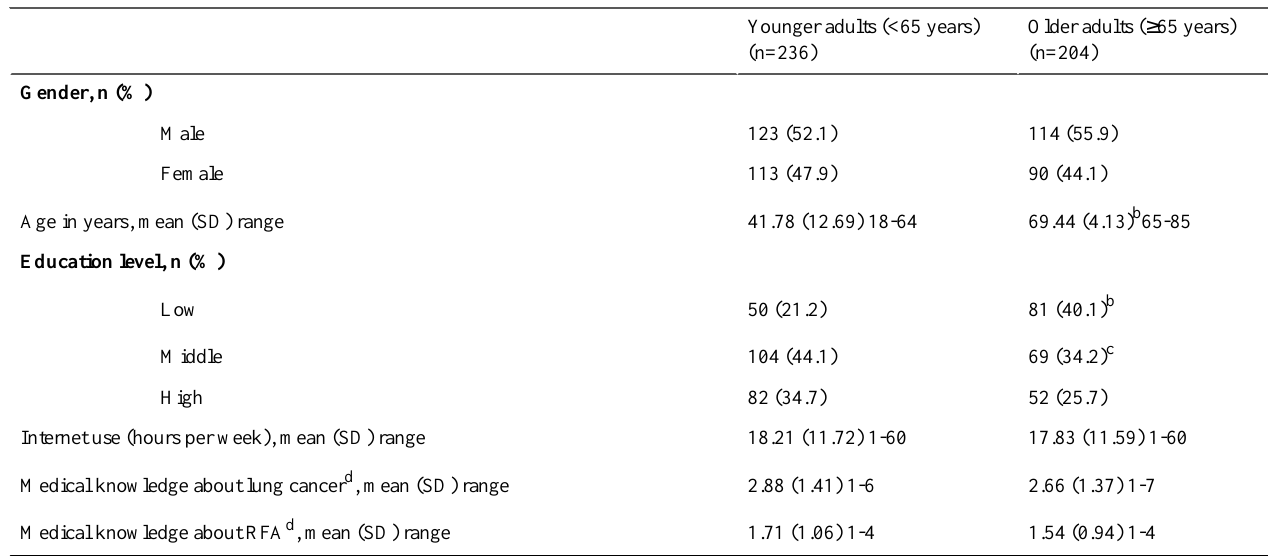
Table 1. Sample characteristics (N=440).